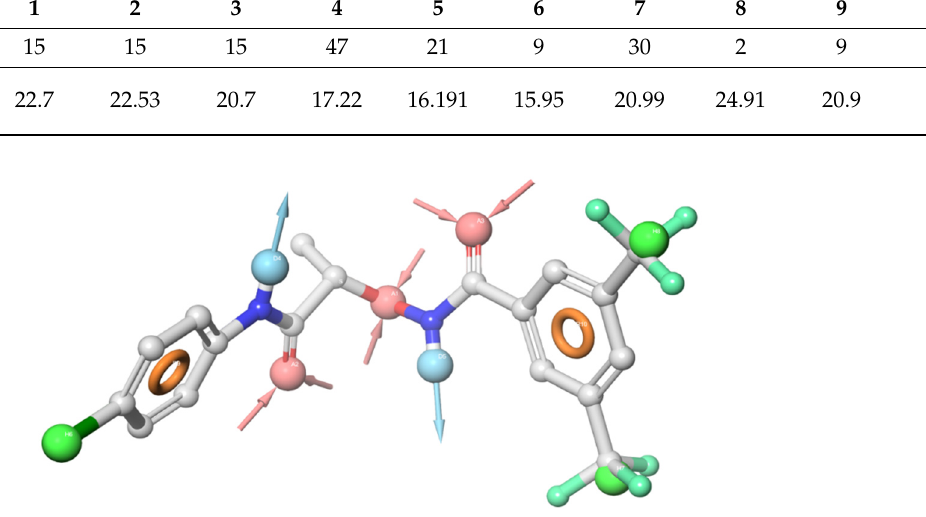
Figure 3. Ball and stick 3D representation of the lowest-energy minimum conformation of compound 1 (Cluster 4, S stereoisomer). Points used by Phase module of Schrödinger suite for the superposition with the newly synthesized compounds were